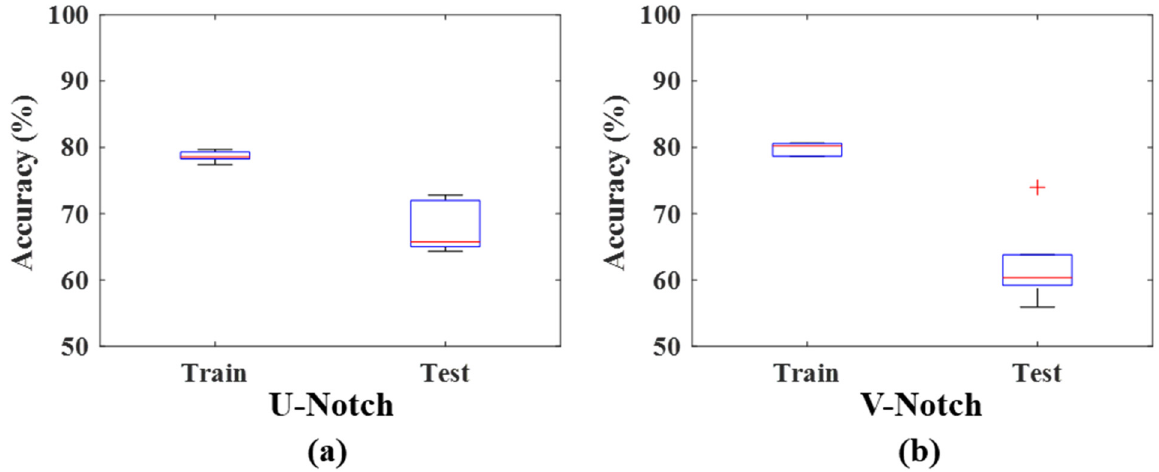
Figure 16. Average training and testing accuracy across all hold-out-based validation iterations for ( a ) U-notched and ( b ) V-notched specimens in the CC regime. The red lines denote the medians of the distributions.